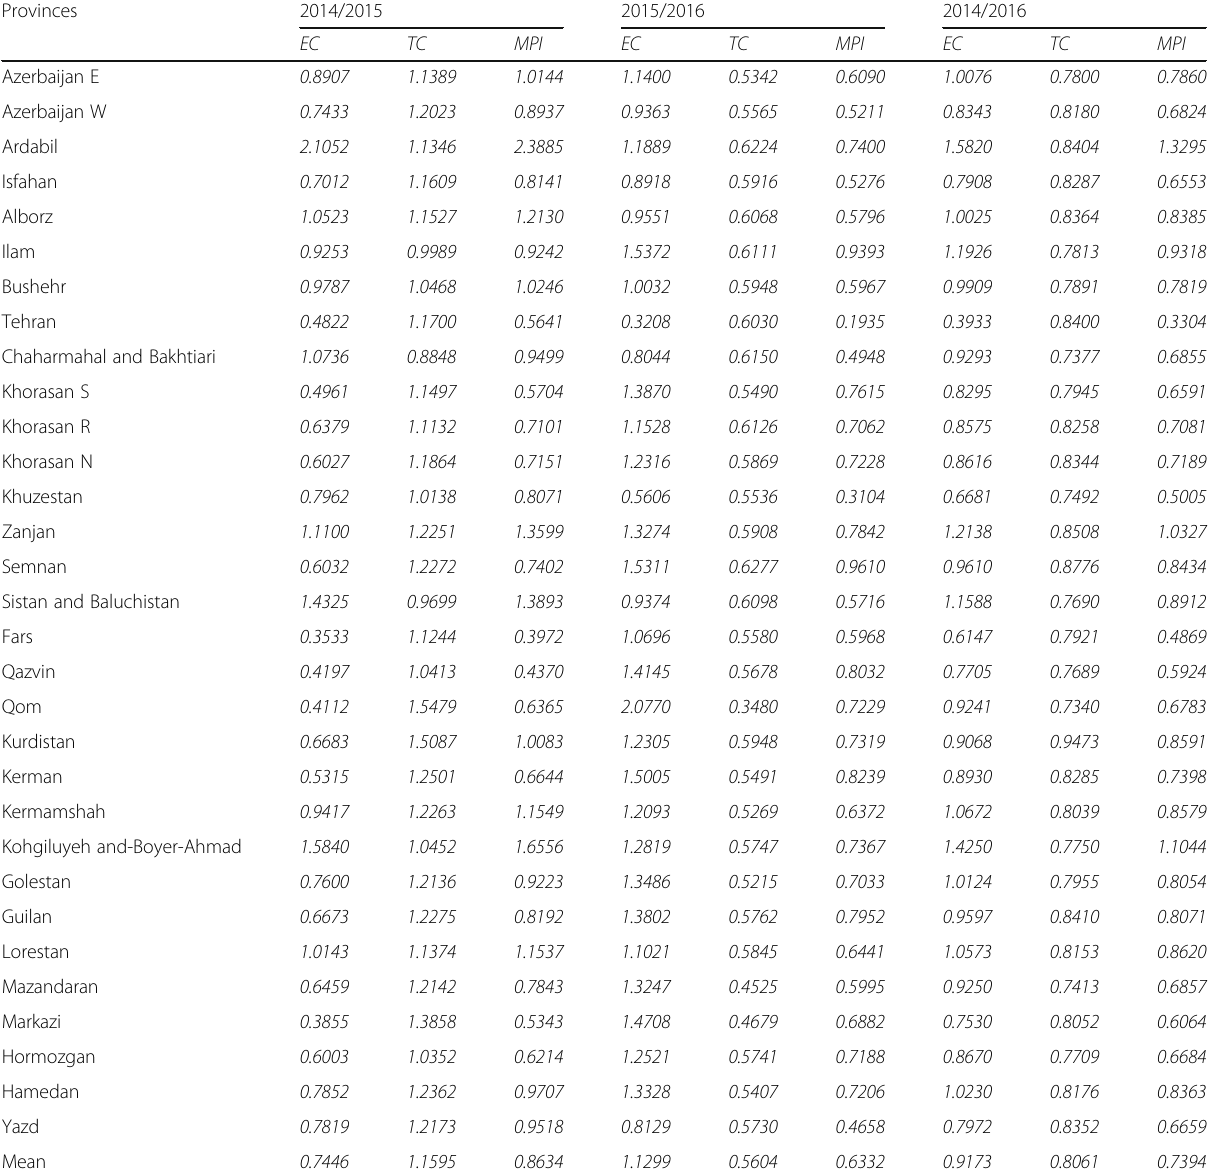
Table 9 The double-frontier MPI for the three-year evaluation (2014-2016)